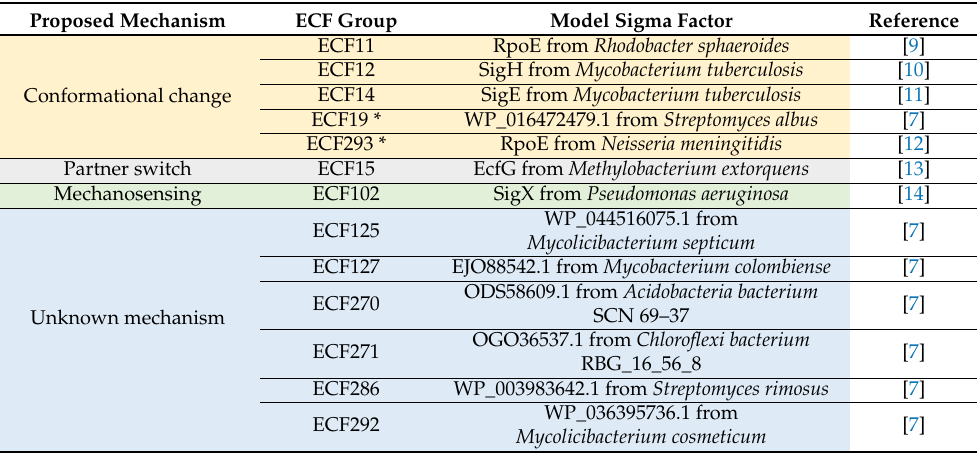
Table 1. Different regulatory mechanisms of the ECF sigma factors with soluble anti-sigma factors. The ECF groups are those that appear in the new classification of Casas-Pastor et al., 2021 [7]. * Only certain members of the